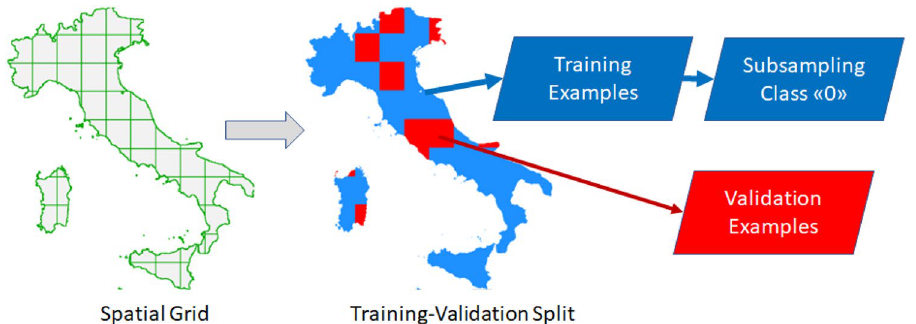
Figure 3. The Italian peninsula is covered by large cells (5000 km 2 each) to perform a hold-out spatial CV procedure. Training and validation examples were assigned to different cells so that the model would not be trained on adjacent grid points (except for points along the cell borders). Furthermore, training examples were subsampled to ensure a balanced ratio between the two classes. The map was produced by using the plot.raster function from "raster" R